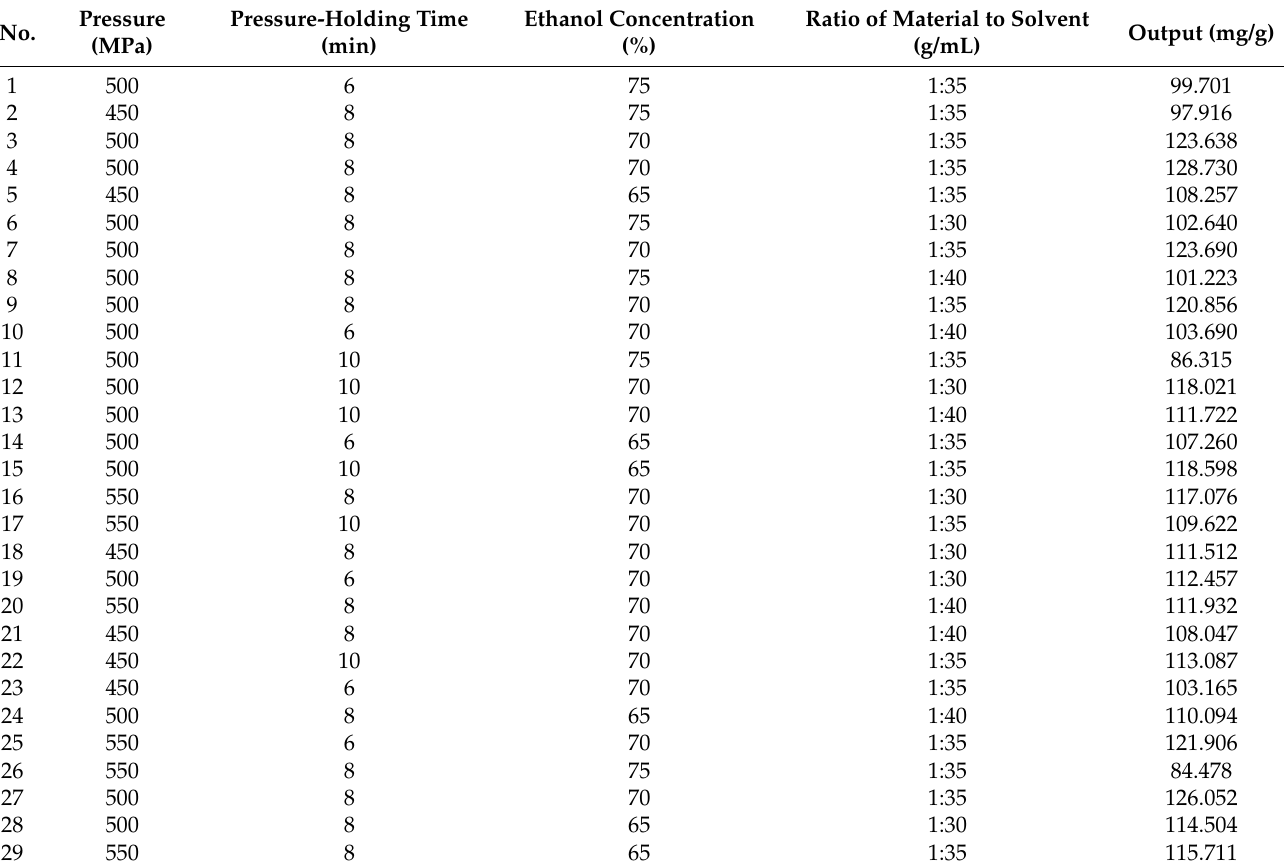
Table 1. Box–Behnken experimental design and the extraction output of total saponins from M. charantia ( n = 3). Each determination was made in triplicate.